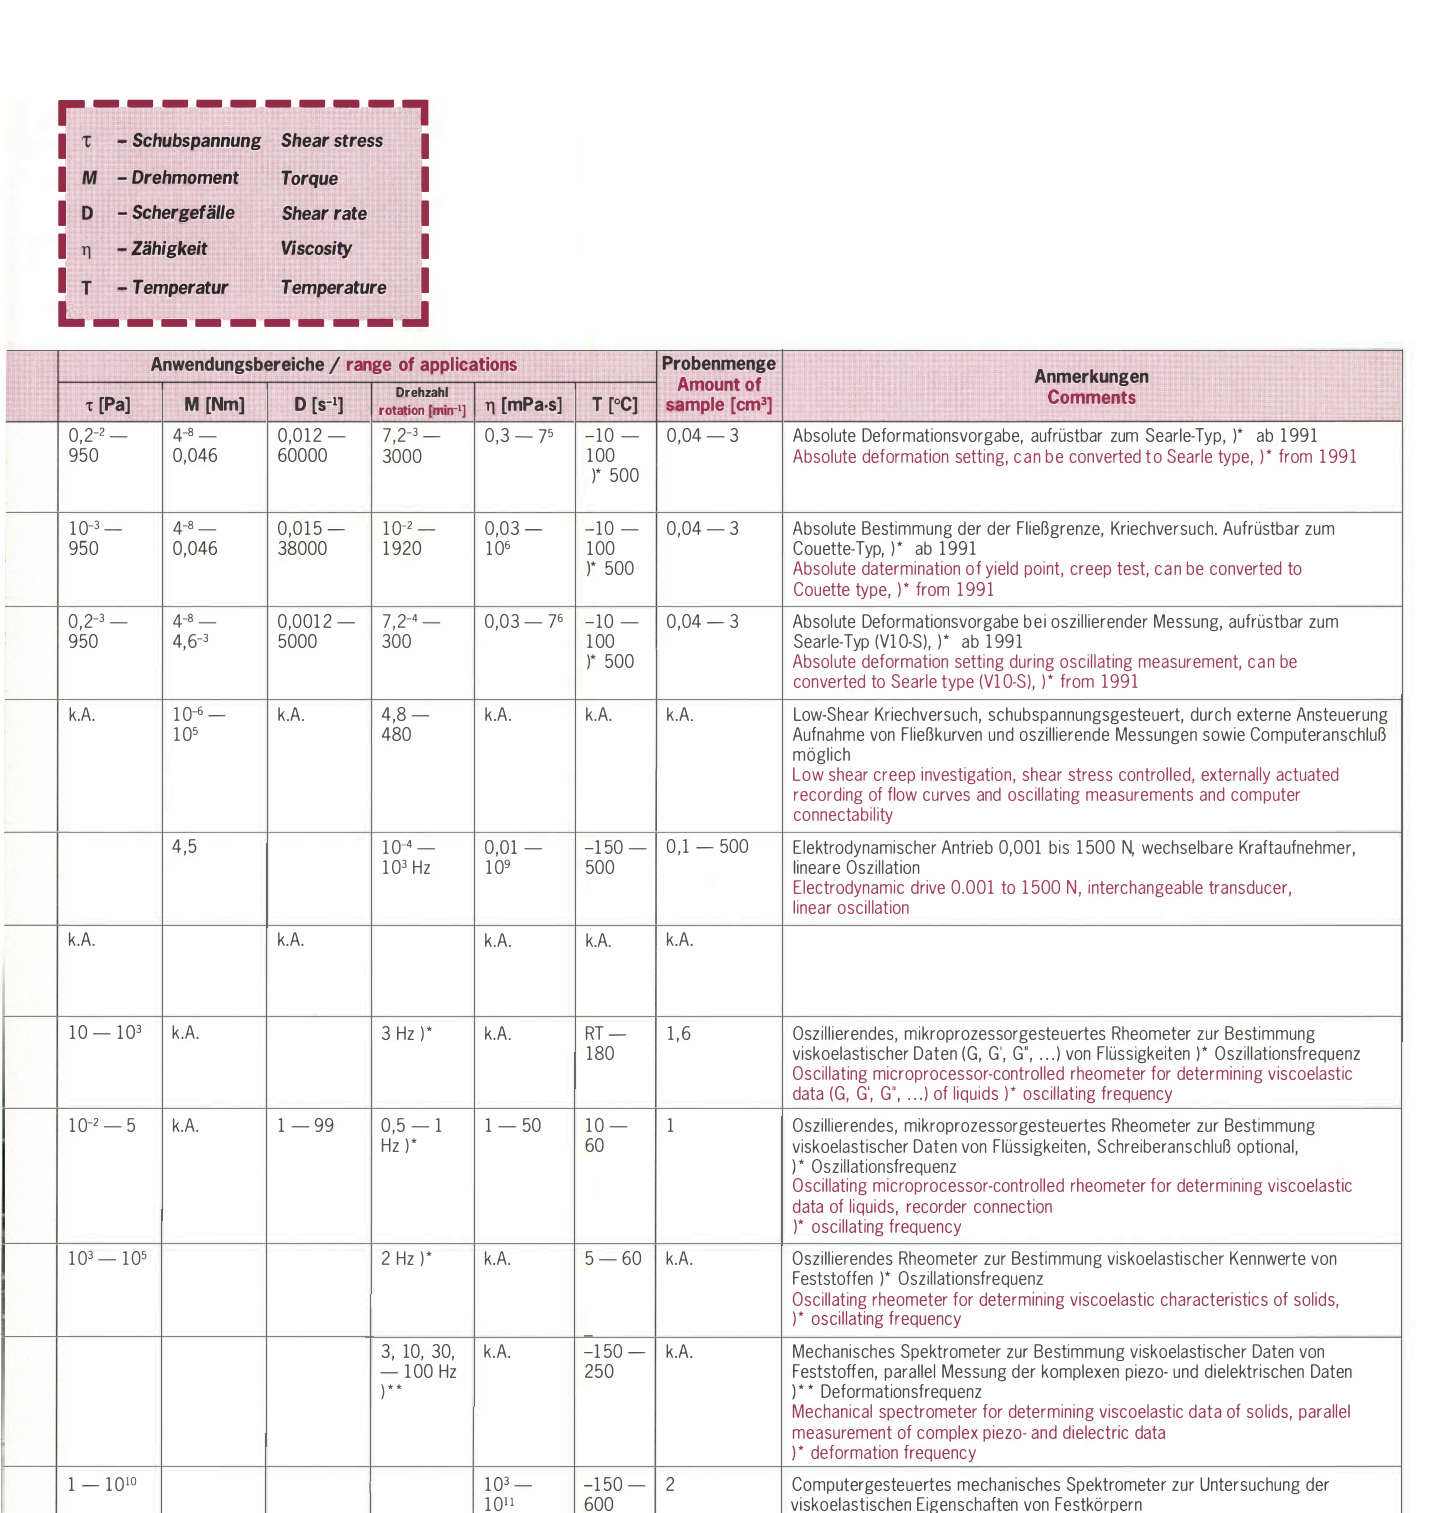
) • • Deformationsfrequenz Mechanical spectrometer for determining viscoelastic data of solids, parallel measurement of complex piezo-and dielectric data ) • deformation